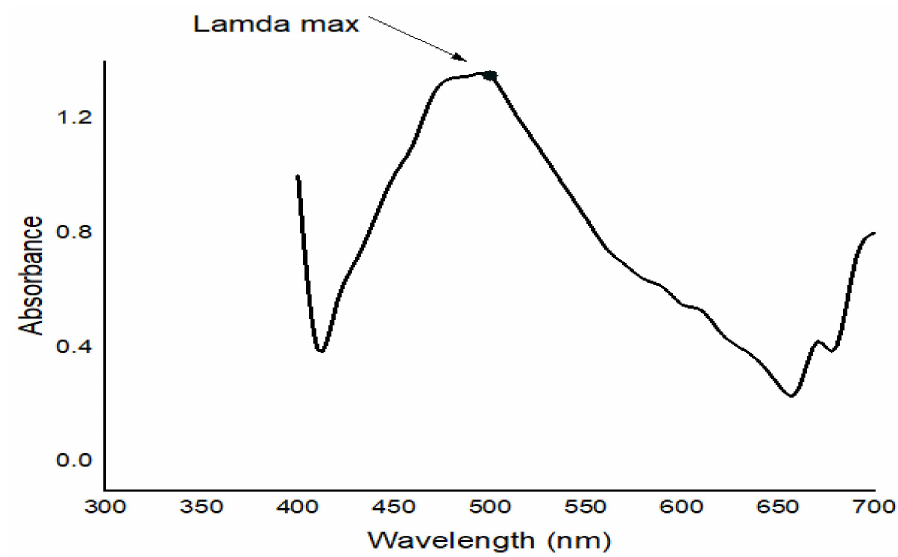
Figure 1. UV–VIS spectrum of Ag-NPs synthesized by the crude aqueous extract from Moringa and NaBH 4 .